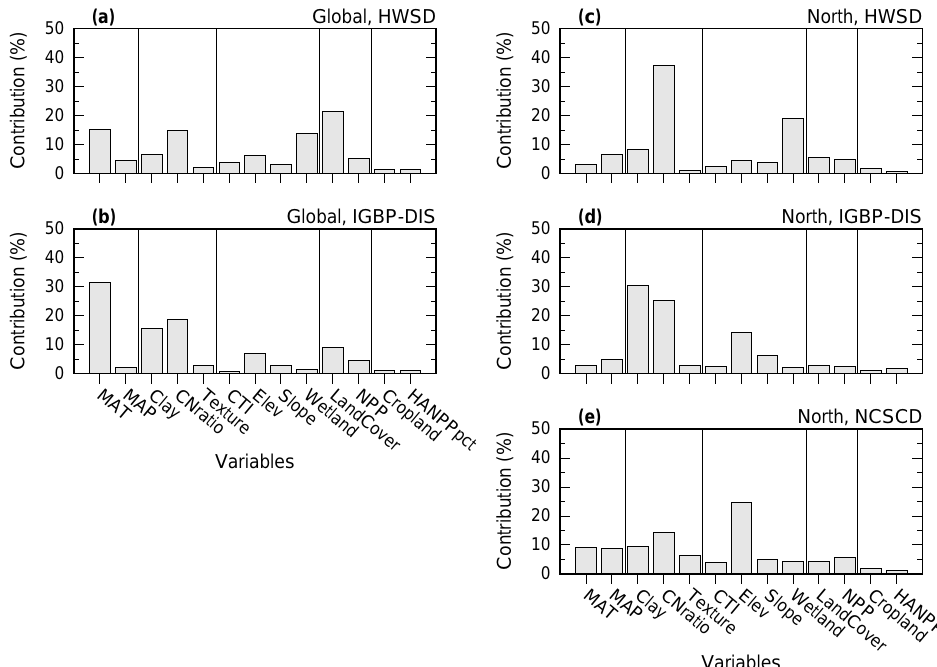
Figure 3. Relative contribution (influence) of predictive variables for the model of soil carbon stocks in the global observational databases (left) and northern observational databases